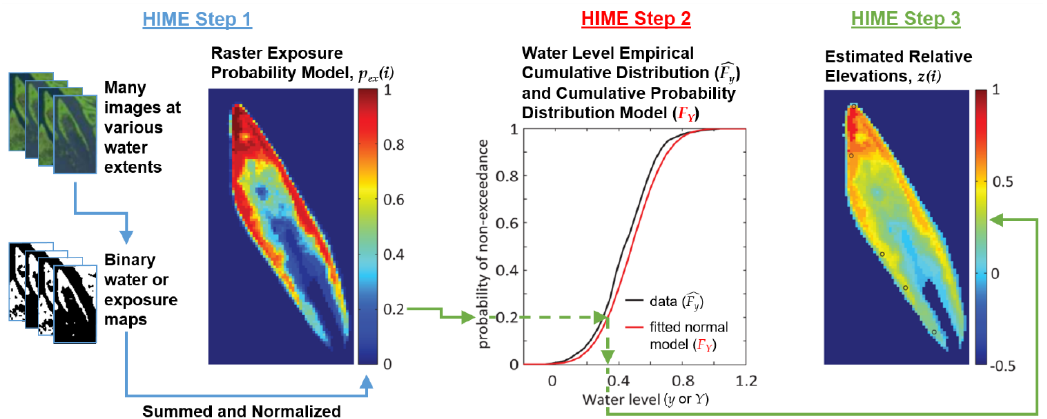
Figure 2. Schematic of Hindcasting Intertidal Marsh-top Elevation (HIME) method: Step 1, calculate a time series of raster exposure probability models from remote sensing images; Step 2, fit a water level cumulative probability of non-exceedance distribution function to available water level data; Step 3, combine the results of Step 1 and Step 2 to produce a time series of estimated marsh-top elevation models.